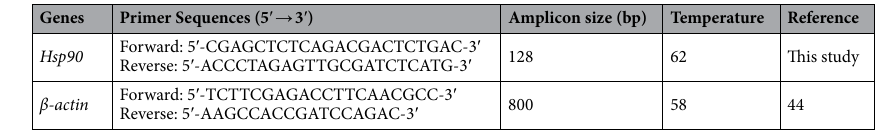
Table 2. Primer sequences used for quantifying the expression levels of HSP90 gene in T.